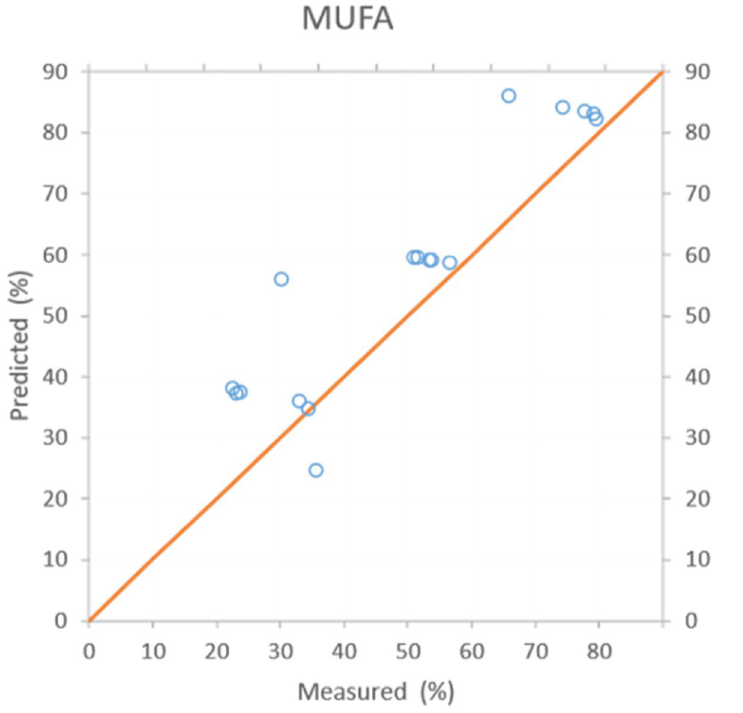
Fig 6. Predicted versus measured for MUFA using PCR regression model (R 2 =